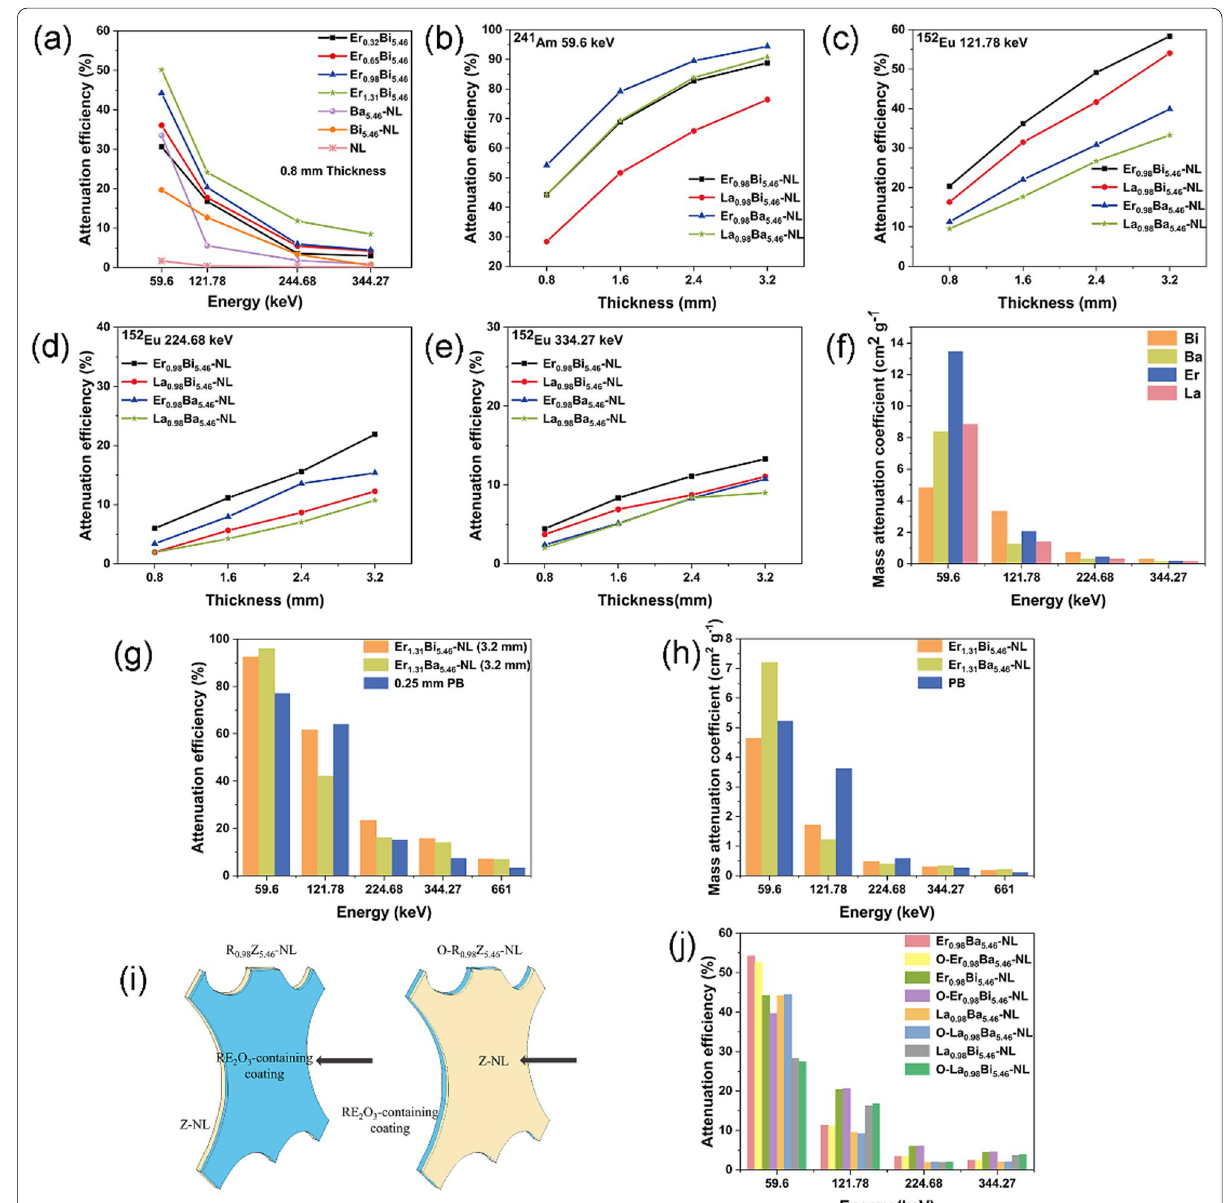
Fig. 3 a Attenuation efficiency of Er y Bi 5.46 -NL, Bi 5.46 -NL, Ba 5.46 -NL, and NL under different energies; Attenuation efficiency of R 0.98 Z 5.46 -NL in the incidents of b 59.6; c 121.78; d 244.68; and e 344.27 keV; f Mass attenuation coefficient of Bi, Ba, Er, and La in NIST-XCOM; g Attenuation efficiency of 3.2-mm Er 1.31 Z-NL and 0.25-mm lead plate; h Mass attenuation coefficient of Er 1.31 Z-NL and 0.25-mm lead plate; i Diagrams of R 0.98 Z 5.46 -NL and O-R 0.98 Z 5.46 -NL; j Attenuation efficiencies of R 0.98 Z 5.46 -NL and O-R 0.98 Z 5.46